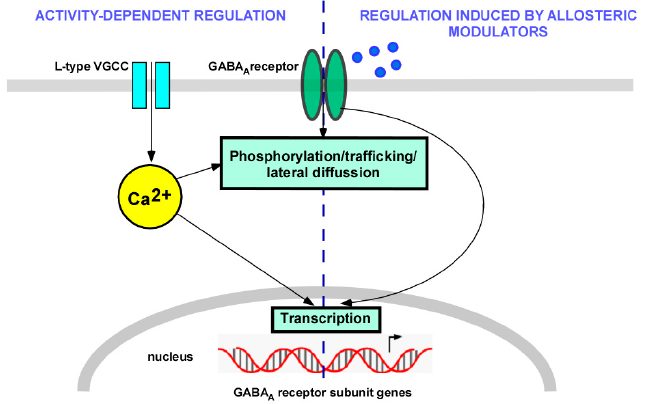
Figure 1. Regulation of GABA A receptors by calcium and allosteric modulators. Calcium entering through L-type voltage- gated calcium channels (VGCCs) as a consequence of membrane depolarization can regulate GABA A receptors’ function by means of changes in transcription, phosphorylation, trafficking, and lateral diffusion of receptors on the plasma mem- brane. These processes can also be regulated by the prolonged exposure of receptors to different allosteric